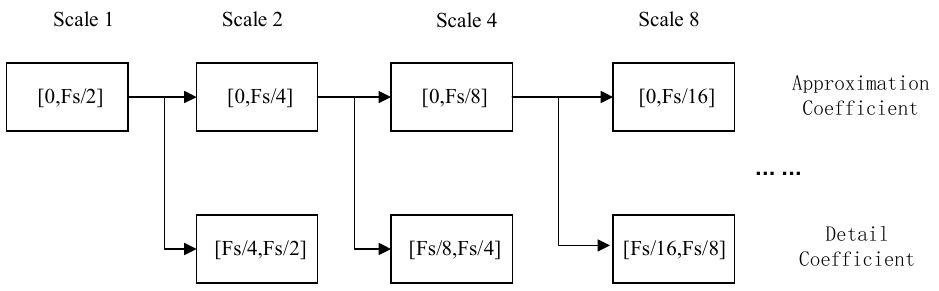
Figure 2. Tree structure of signal decomposition by discrete wavelet transform (DWT).